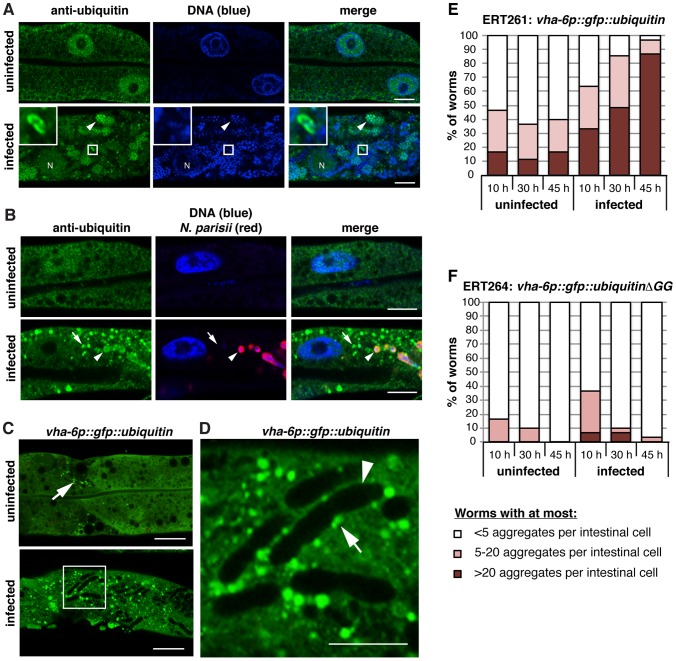

N. parisii cells are almost never targeted by ubiquitin later during infection, but ubiquitin forms clusters that accumulate in the C. elegans intestine.A,B) C. elegans intestines stained an anti-conjugated-ubiquitin antibody FK2 (green), and DAPI for DNA (blue): Panel B also includes a FISH probe against N. parisii rRNA (red). A) Sections of uninfected and N. parisii-infected C. elegans intestines. In the infected intestine an N. parisii spore labeled with the anti-conjugated-ubiquitin antibody is enlarged in box inset in upper left, and meront (arrowhead), and host nucleus (N) are indicated. Scale bar  = 10 µm. B) Sections of uninfected and N. parisii-infected C. elegans intestines (30 hpi) shown with ubiquitin cluster (arrow) and ubiquitin staining within an N. parisii meront (arrowhead) indicated. Scale bar  = 10 µm. C) Intestines of uninfected and infected animals expressing an intestinal GFP::ubiquitin transgene (48 hpi, grown at 20°C to prevent construct aggregation) are shown. Small GFP::ubiquitin aggregates are sometimes observed in uninfected animals (arrow). Scale bar  = 20 µm. D) Enlarged portion of box in panel C. Oblong N. parisii meronts are visible through the absence of green (arrowhead) and ubiquitin clusters associating with the meronts (arrow) are indicated. Scale bar  = 10 µm. E) Animals expressing the intestinal GFP::ubiquitin construct were infected with N. parisii and, together with control uninfected animals, fixed at the indicated times. Fixed animals were stained with a FISH probe against N. parisii rRNA to mark the infection and their intestinal cells were inspected for visible GFP::ubiquitin aggregates (30 transgenic animals were inspected per timepoint and condition). F) Animals expressing the intestinal control GFP::ubiquitinΔGG construct were treated and analyzed as in E.